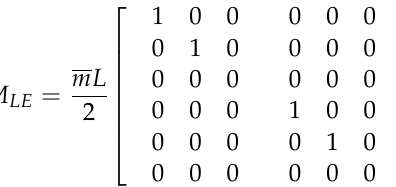
Figure 4. DOFs of a prismatic member with straight axes of a plane frame.